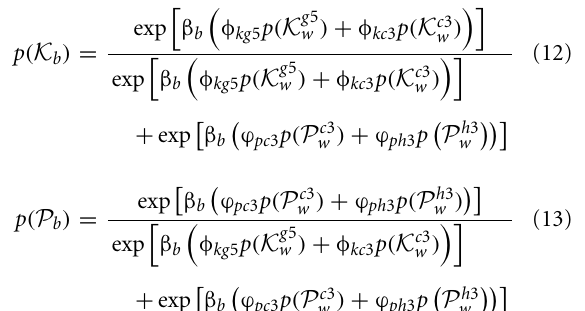
Black to understand White’s preferences for their next move, Black needs to encode a representation of the way in which White will select their move. This is the same process as Black uses to make their decision but using information pertinent to White’s strategic